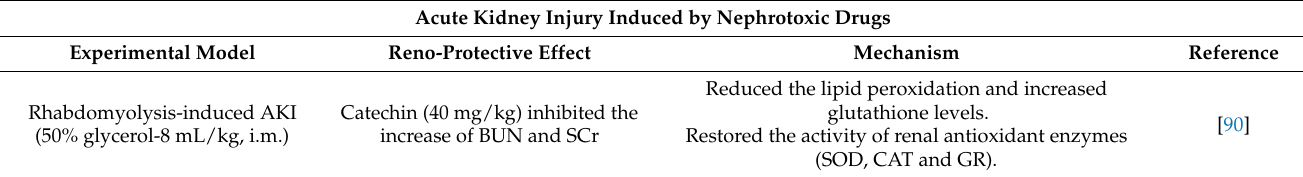
Table 1. Reno-protective effects of catechins in animal models of acute kidney injury (AKI).